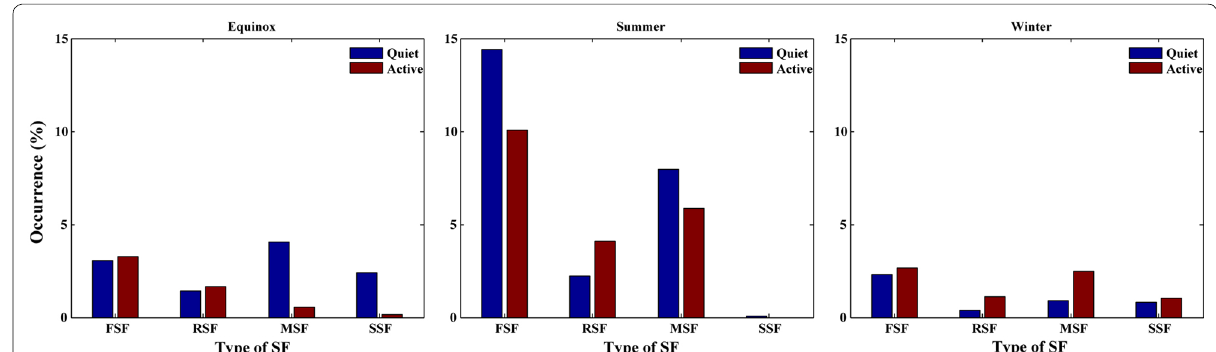
Fig. 5 The occurrence rates of four types of SF under different geomagnetic conditions in